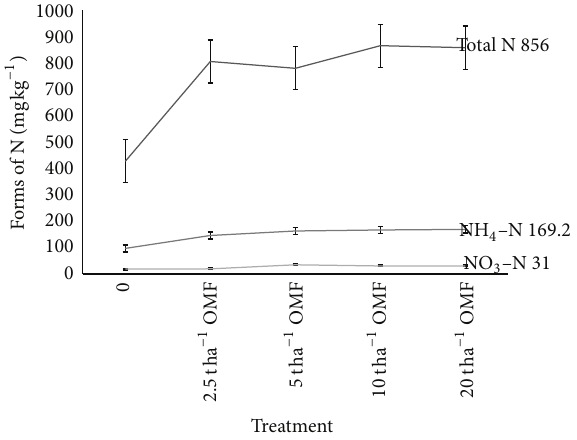
Figure 1: Effect of organomineral fertilizer on forms of N. Total N